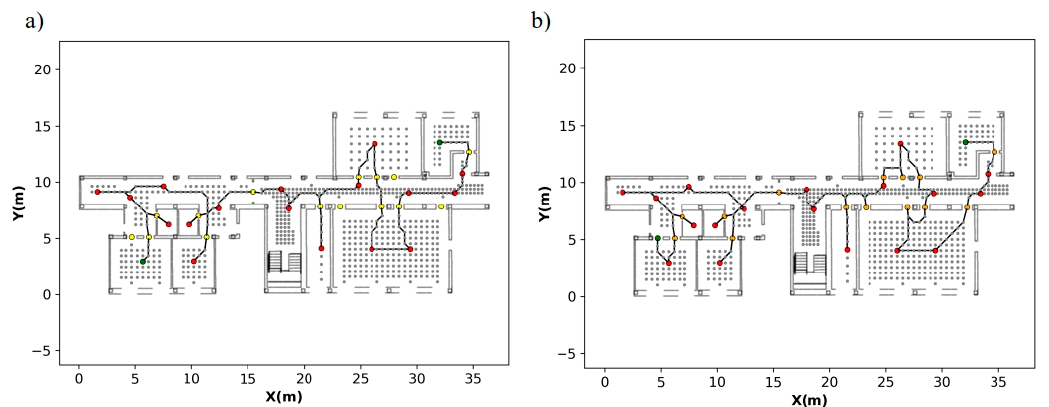
Figure 23. Optimal route calculated in case study 1 with scan positions at doorways in ( a ) and without scan position at doorways in ( b ). Color code: scan positions (red points), graph nodes (gray points), start-end positions (green points), scanning-door positions (orange).